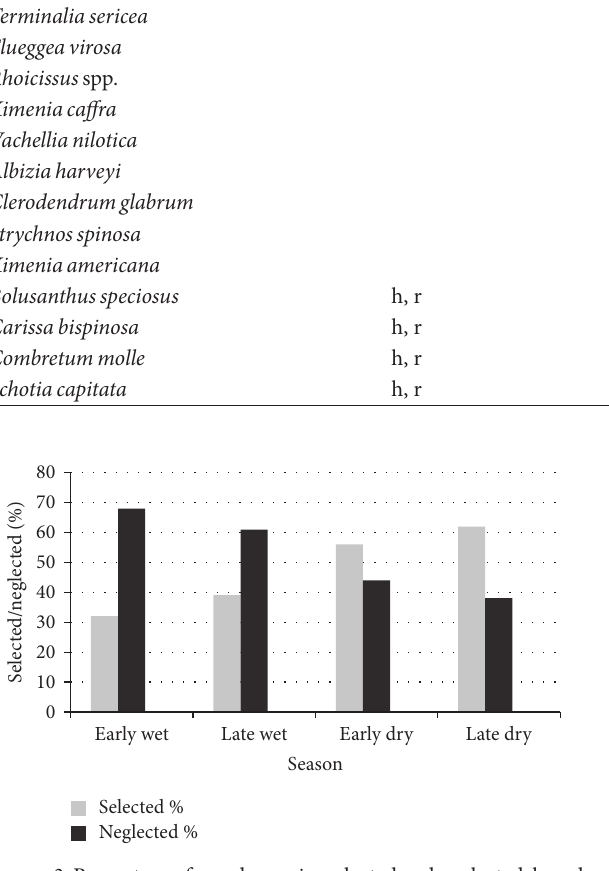
Figure 3: Percentage of woody species selected and neglected, based on Manly’s alpha values, in the feeding areas selected by breeding herds of African elephants from March 2002 to September 2005 in the southern Kruger National